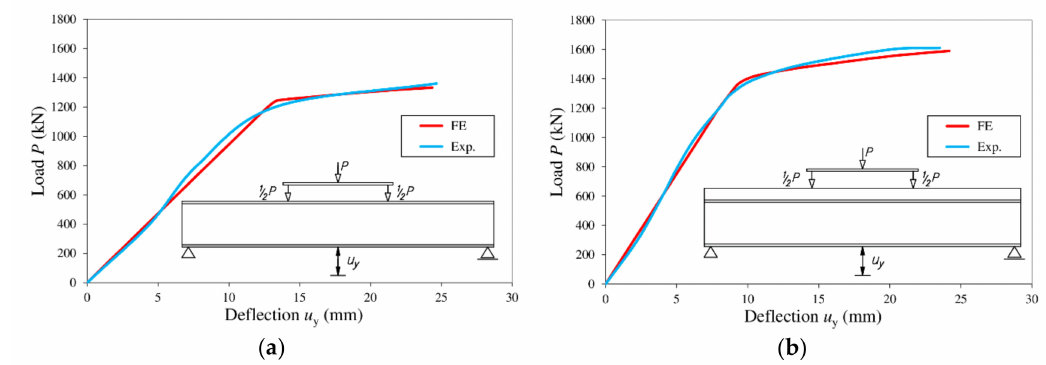
Figure 10. Comparison of vertical displacements determined through experimental tests and numerical analysis: ( a ) steel beam; ( b ) steel beam bonded to a reinforced concrete slab.